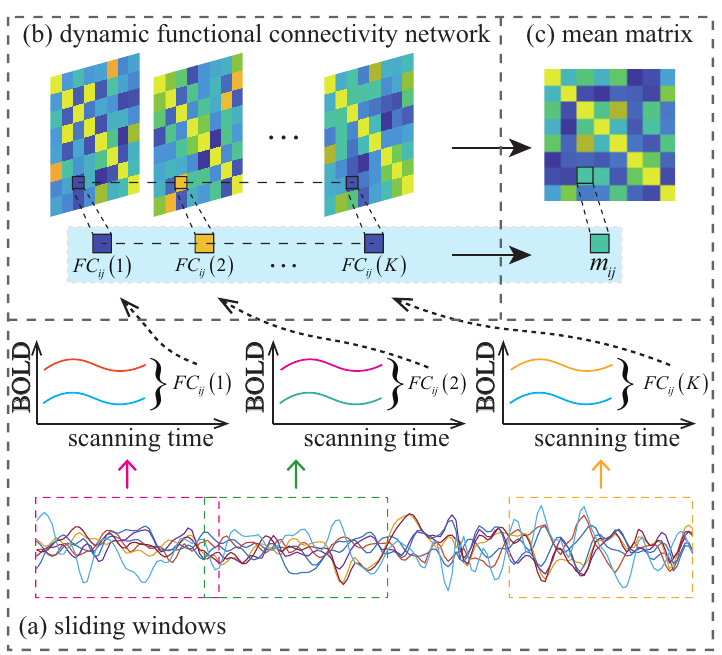
Figure 1. The illustration of constructing the D-FCN. The FC ij ( k ) 1 (cid:54) k (cid:54) K denotes the temporal correla- tion of the i -th and j -th ROI in the k -th segment.